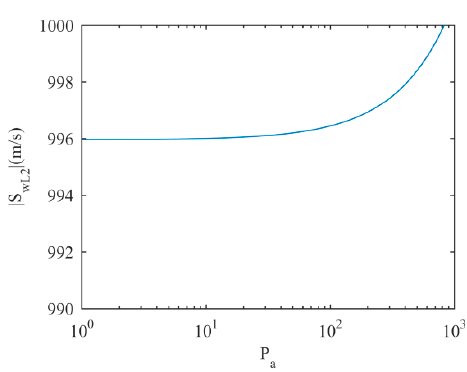
Figure 12. | S wL2 | under different values of P a .